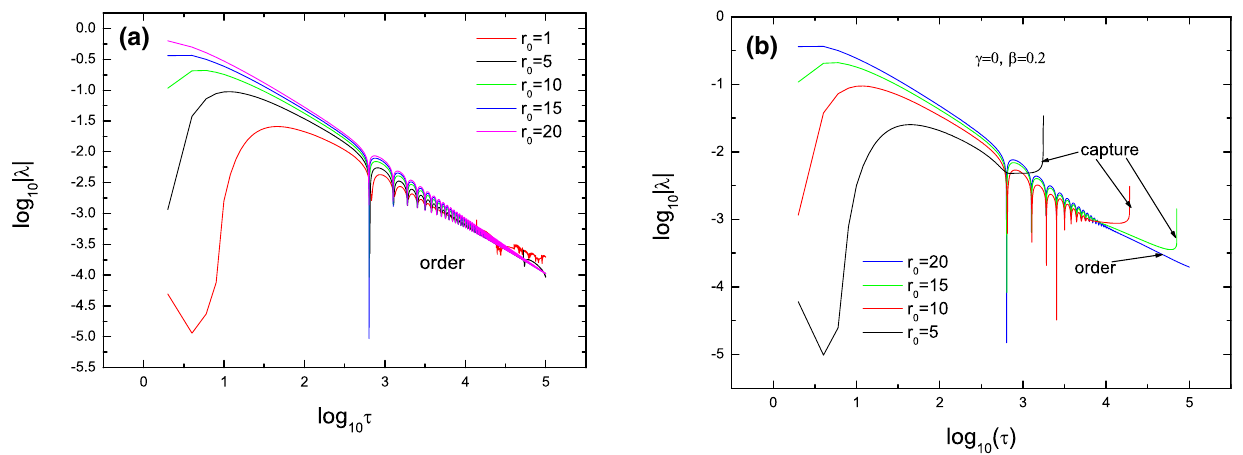
Fig. 4 Left plot: The maximum Lyapunov exponents of the string motion with different r 0 in flat space ( γ = 0 and β = 0). Right plot: The maximum Lyapunov exponents of the string motion with different r 0 over the asymptotically flat Schwarzschild black hole ( γ = 0 and β = 0 . 2)